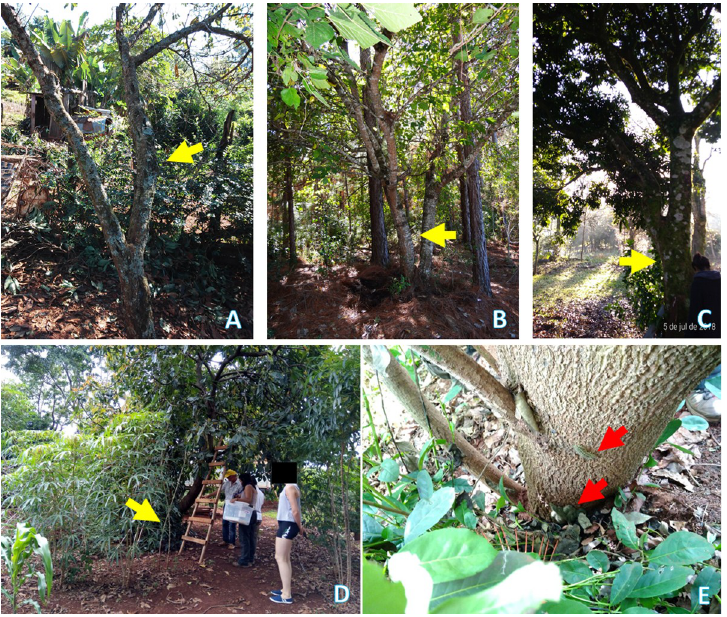
Fig 7. Fruit trees (indicated by yellow arrows) hosting Lonomia caterpillars involved in cases of lonomism in Misiones, Argentina. A - A plum tree with a fork that the victim used to climb the tree. B - A blackberry tree. C - A mango tree. D - A big palta tree hosting Lonomia in the lower part of its trunk. This part of the tree can be seen closer in E , where red arrows indicate the caterpillars.